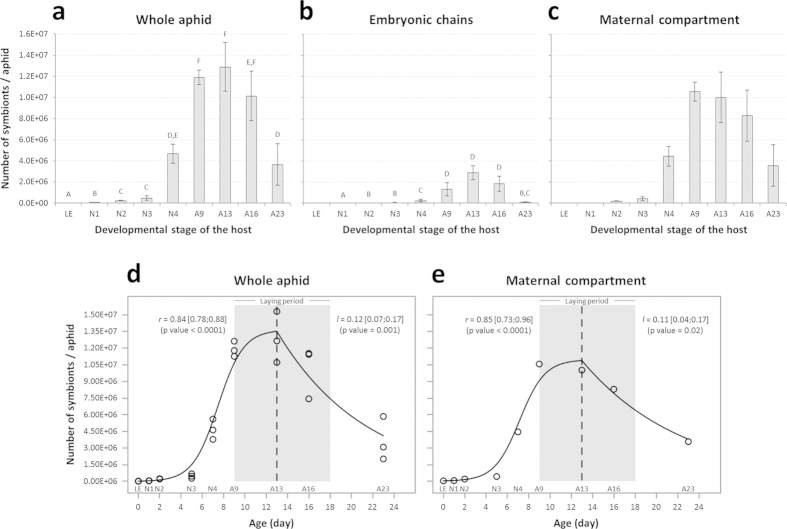
Dynamics of B. aphidicola population during aphid development.(a,b) Variation in the number of symbiont cells, quantified by flow cytometry analysis from whole aphids (a), or embryonic chains (b), in relation to host developmental stage. Results are reported as means ± SD; n = 3 independent biological replicates per stage (each biological replicate was composed of 10 aphids). Data (after log-transformation) were analyzed by one-way ANOVA followed by a post hoc multiple comparisons test (Tukey’s HSD test). Developmental stages labeled with different letters are significantly different (P < 0.05). (c) Variation in the number of B. aphidicola cells in maternal bacteriocytes, as calculated by subtraction of embryonic chains from whole aphids sample means, in relation to host developmental stage. Results are reported as means ± SD* . (d,e) Modeling of B. aphidicola population dynamics in whole aphids (d) or maternal bacteriocytes (e) during aphid development. A logistic model was applied for the first part of the dynamics (n0 fixed), followed by an exponentially decreasing model. The rupture point (vertical dashed line) was visually determined. The predicted value of the logistic model at this rupture point was used to fix Nmax in the exponentially decreasing model for ensuring continuity and improving the estimation of the population decreasing rate. Population growth, r, and decreasing rates, l, are shown on the figure, with their 95% confidence interval. Abbreviations: LE, late embryos; N1 to N4, nymphal stages from 1 to 4; A9-A23, adult time points from day 9 to day 23. Shaded grey area indicates the laying period.